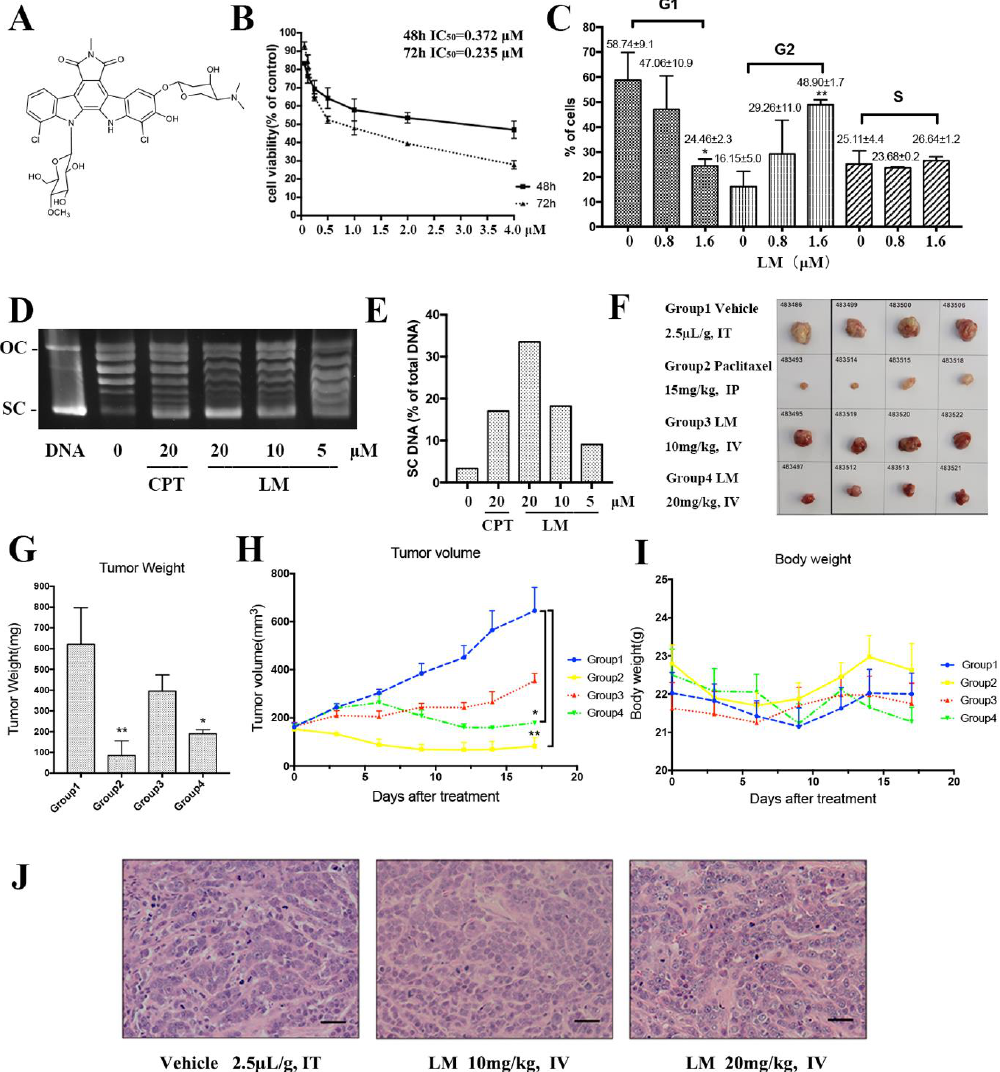
Figure 1. LM targets TNBC in vitro and in vivo. ( A ) The structure of LM; ( B ) the cell viability experiment of LM on human TNBC cell line MDA-MB-468. The MDA-MB-468 cells were treated with 0, 0.0625, 0.125, 0.25, 0.5, 1, 2,4 µ M LM for 48 and 72 h, and the cell viability was detected by the CCK8 assay; ( C ) effects of LM at 0.8 µ M and 1.6 µ M on MDA-MB-468 cell cycle arrest after 48 h of incubation. Cells were stained with Annexin V and analyzed by flow cytometry. The vertical bars represent the standard deviation of means (SD) ( n = 3 experiments); * p < 0.05 and ** p < 0.01, vs. negative control. The G1, G2 and S represent the phase of the cell cycle. ( D ) The inhibitory effect of LM on topoisomerase I activity. The plasmid was treated with 5, 10, 20 µ M LM and the 20 µ M camptothecin (CPT) was used as positive control. ( E ) The quantification of electrophoretic band. The Y axis is SC DNA/total DNA. ( F ) The images of tumors from each group. Tumor-bearing mice were administered the vehicle (negative control), 15 mg/kg Paclitaxel (positive control), LM (10 or 20 mg/kg per day). ( G ) The average tumor weight in each group. Data are presented as the mean ± S.D. n = 4, * p < 0.05 and ** p < 0.01, vs. negative control. ( H ) The average tumor volume in each group recorded during the treatments. Data are presented as the mean ± S.D., n = 4, * p < 0.05 and ** p < 0.01, vs. negative control. ( I ) The average body weight in each group. ( J ) The HE staining on stripped tumor